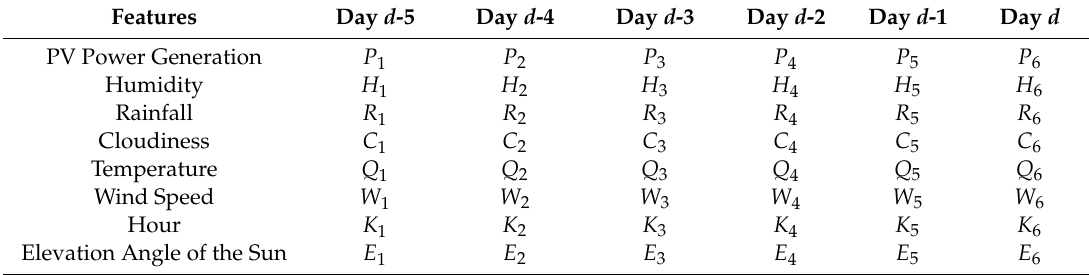
Table 1. Notation of features for each